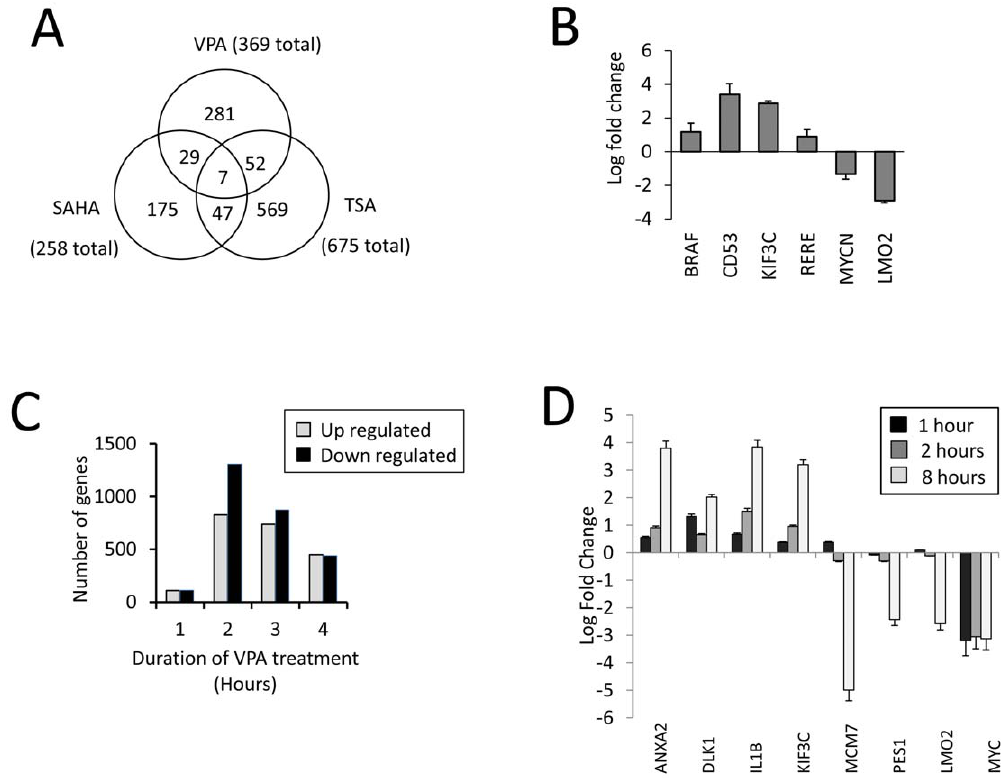
Figure 2. Changes in transcript level induced by HDACi. ( A ) Venn diagram showing genes where transcript levels changed significantly (p , 0.01) in response to HDACi, detected by HGMP 5K array (5000 gene probes). HL60 cells were treated with VPA (5 mM), SAHA (2.5 m M) or TSA (165 nM) for eight hours. ( B ) RT-qPCR was used to quantify the transcriptional change at genes that responded to all three HDACi. HL60 cells were treated with VPA (5 mM, 8 hours). Transcript abundance was normalised to b -actin, and presented on a base 2 logarithmic scale. Values are presented with a standard error of mean ( n=3 ). ( C ) Cells were treated with VPA (5 mM), and transcript abundance analysed at defined time points using Operon microarrays (25823 genes). Quantitative presentation of the number of genes that were more than 2-fold up-regulated ( Shaded bars ) or down-regulated ( Filled bars ) at time points during the time course. ( D ) RT-qPCR was used to quantify the transcriptional change at genes that responded to VPA ( 5 mM ) at 1, 2 and 8 hours treatment. Genes show divergent responses, including early and continued up-regulation ( ANXA2, DLK1, IL1B, KIF3C ), little initial change and subsequent down-regulation ( MCM7, PES1, LMO2 ) or early and persistent down-regulation ( MYC ). Transcript abundance was normalised to b -actin, and presented on a base 2 logarithmic